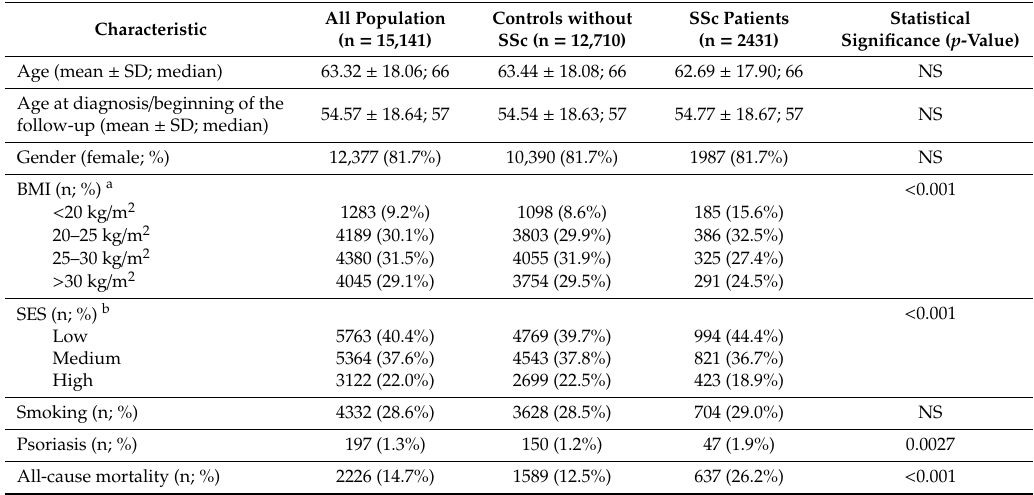
Table 1. Main characteristics of cases (systemic sclerosis (SSc)-patients) and controls recruited. Characteristic